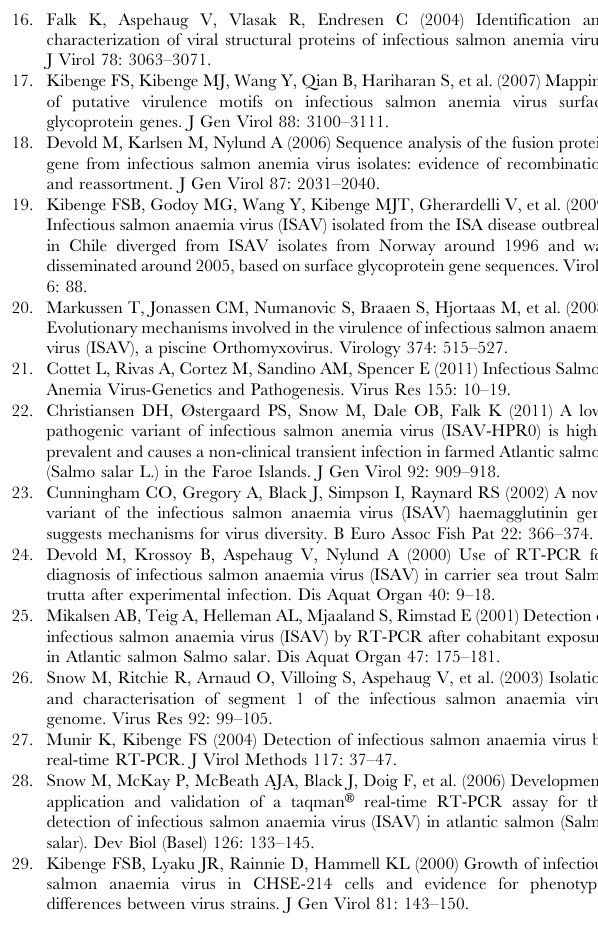
Figure S1 Nucleotide sequence alignment for seven isolates of segment 5. Sequentially: four Norwegian isolates;